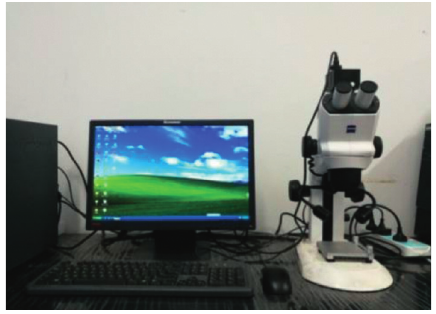
Figure 2: German Zeiss 508 stereo microscope.